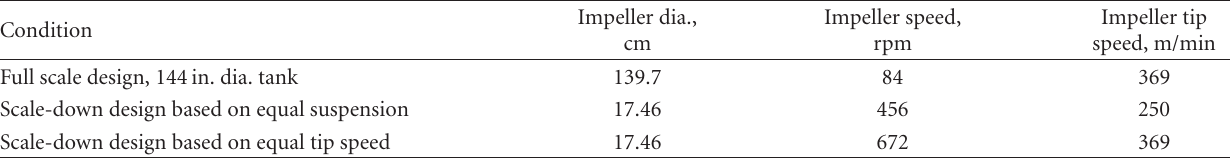
Table 3: Comparison of equal suspension to equal tip